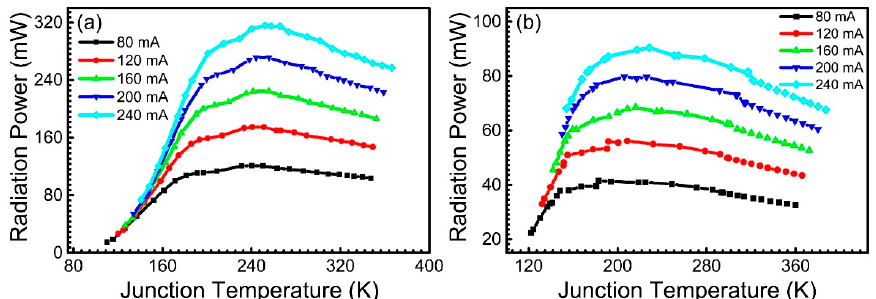
Figure 6. Relationship between radiation power and T j of ( a ) blue and ( b ) green LEDs at different currents.